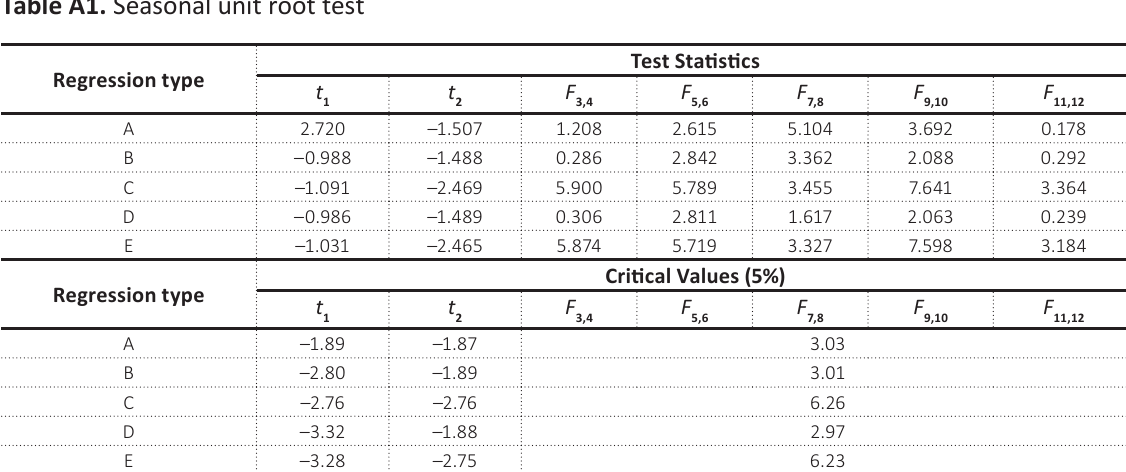
Table A1. Seasonal unit root test